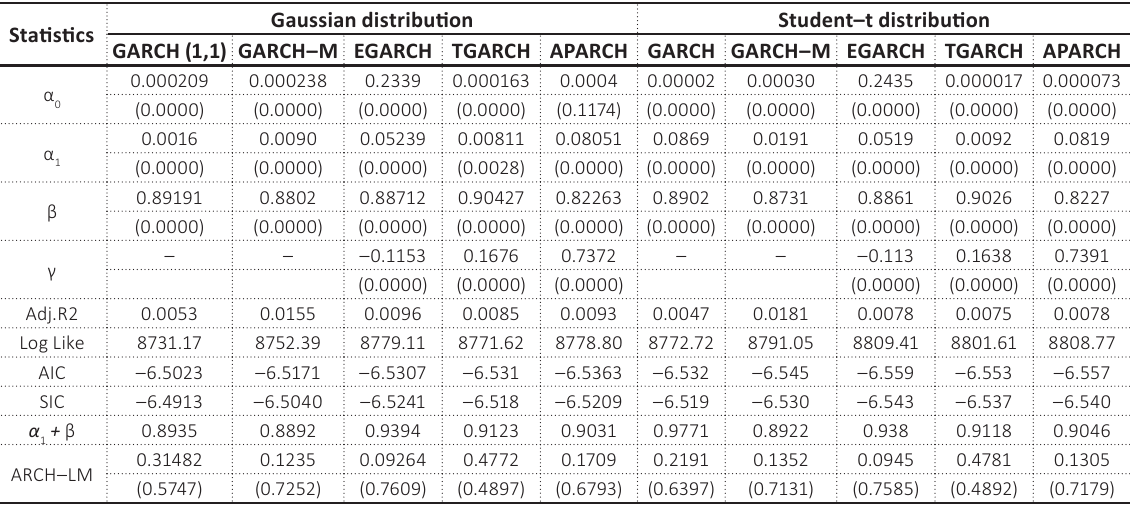
Table 10. Estimation result of GARCH models: